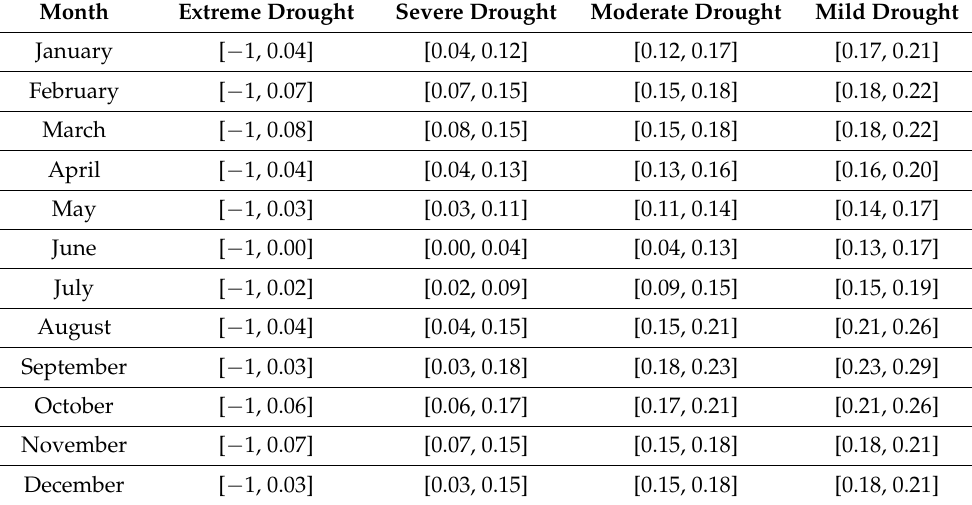
Table 9. The NDVI range for different drought categories for 12 months in 2015 (Grassland Region of